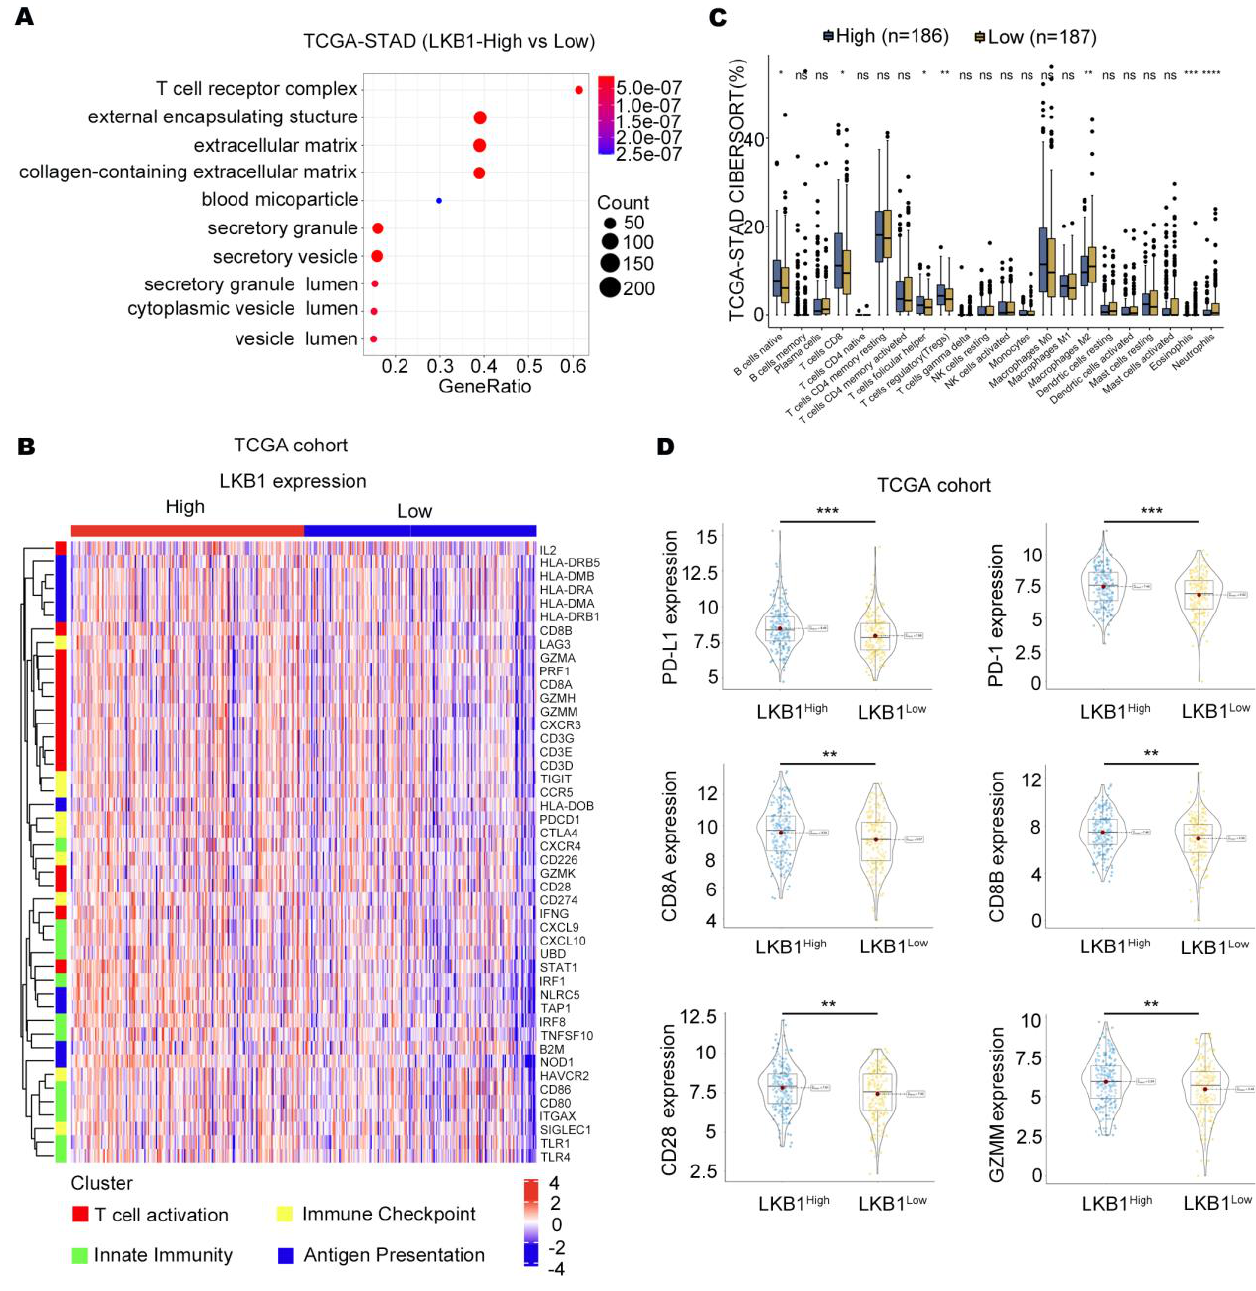
Figure 2. LKB1 is associated with the T − cell activation gene and immune checkpoints. ( A ) T − cell receptor complex showed the greatest difference in the LKB1 high and low expression subgroups. ( B ) CAMOIP database analysis of the differential expression of immune cells between the LKB1 high −and low −expression subgroups. ( C ) The heatmap showing the z − score normalized log − cpm values for signature immune gene sets based on LKB1 expression (n = 407). ( D ) PD − 1, PD − L1, CD8A, CD8B, CD28, and GZMM were highly expressed in the LKB1 − high GC patient subgroup. Unpaired t − test, * p < 0.05, ** p < 0.01, *** p < 0.001.